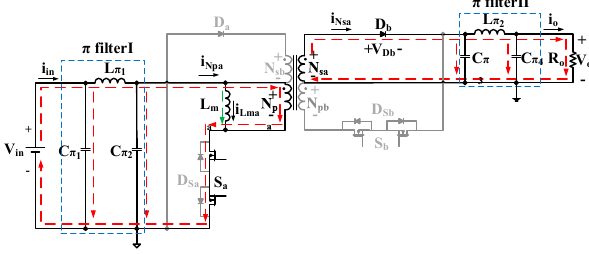
Figure 8. Determine turns ratio by voltage of charging behavior.